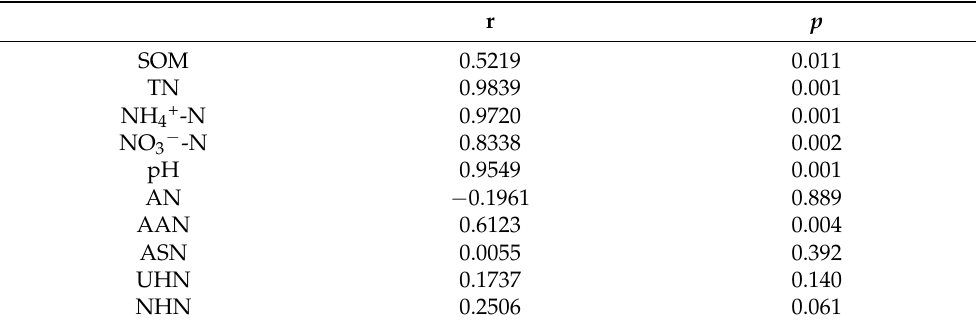
Table 5. Significance tests of the relationship between soil properties and soil cumulative mineralized N based on the Mantel